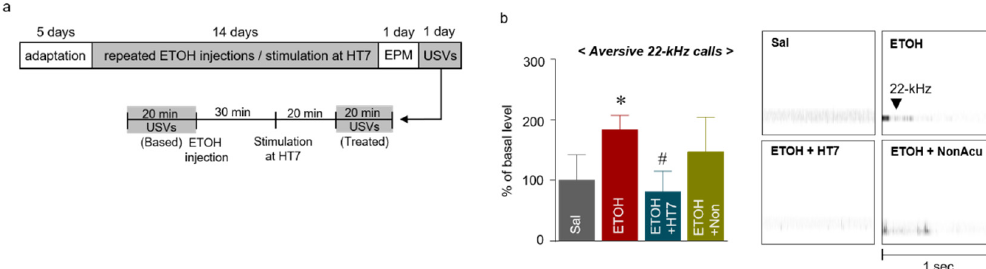
Figure 4. Schematic showing the acupuncture stimulation and schedule for the measurement of ultrasonic vocalizations (USVs) ( a ). Number of 22-kHz USVs emitted during the treatment sessions for 20 min after MAI stimulation (n = 7–9 rats per group) ( b ). The data were analyzed using repeated measures ANOVA followed by Tukey’s test. * p < 0.05 compared with the Sal group and # p < 0.05 compared with the ETOH group. Values are presented as means ± SEM.